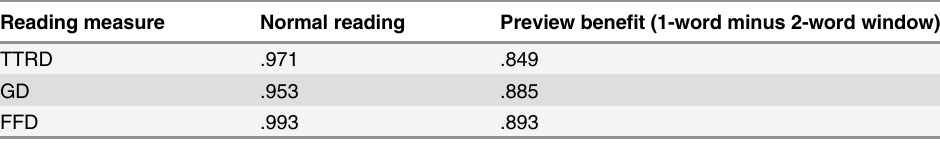
Table 3. Split-half reliabilities for the normal reading condition and the preview bene fi